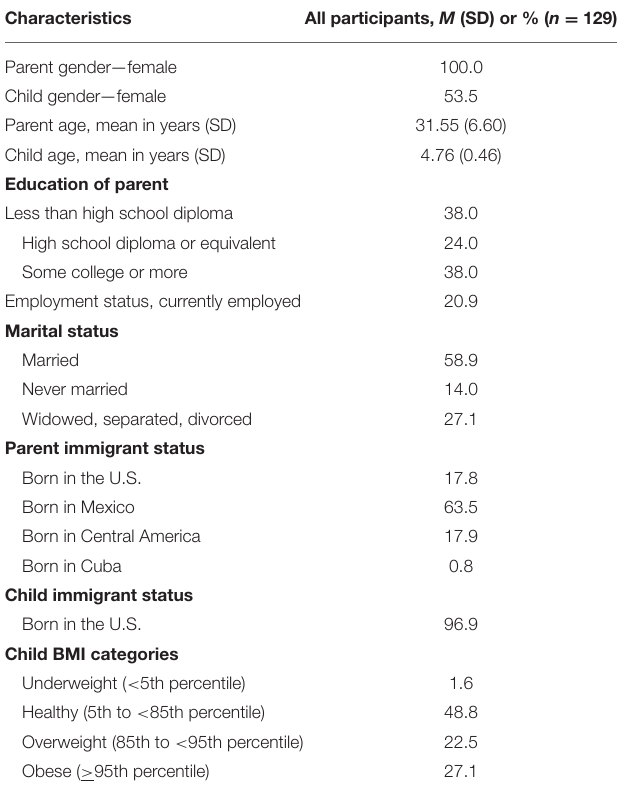
TABLE 1 | Characteristics of the sample at